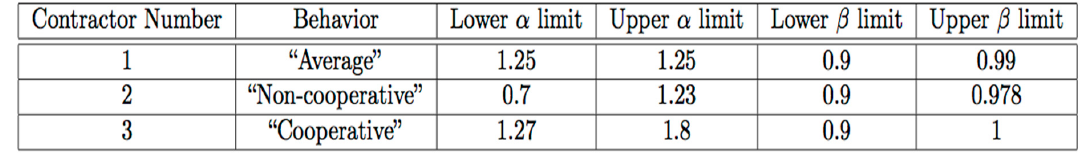
Figure 11. DAA-AWGE CPIF Input. Figure 16 shows a stark difference between the profit earned by optimal bidders and that earned by the non-optimal bidder. Figure 16a depicts that contractor 4 chooses contract parameters